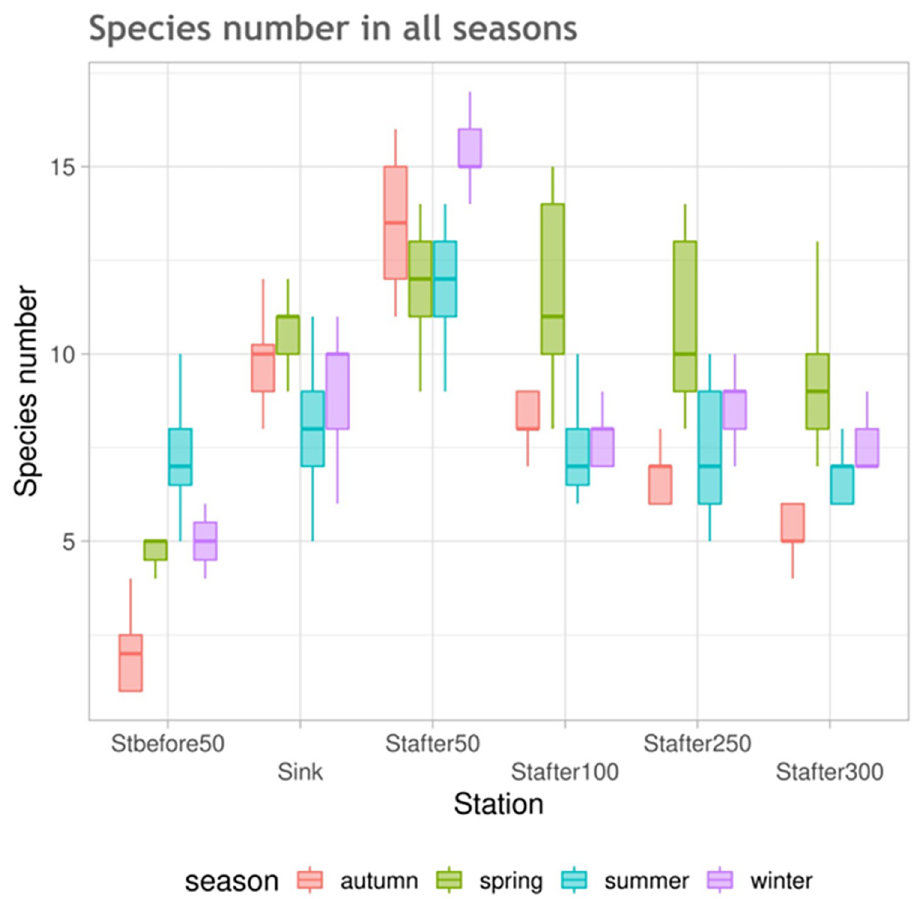
Fig 2. Seasonal changes in the species number by stations in the environmental gradient based on data for the entire study period.